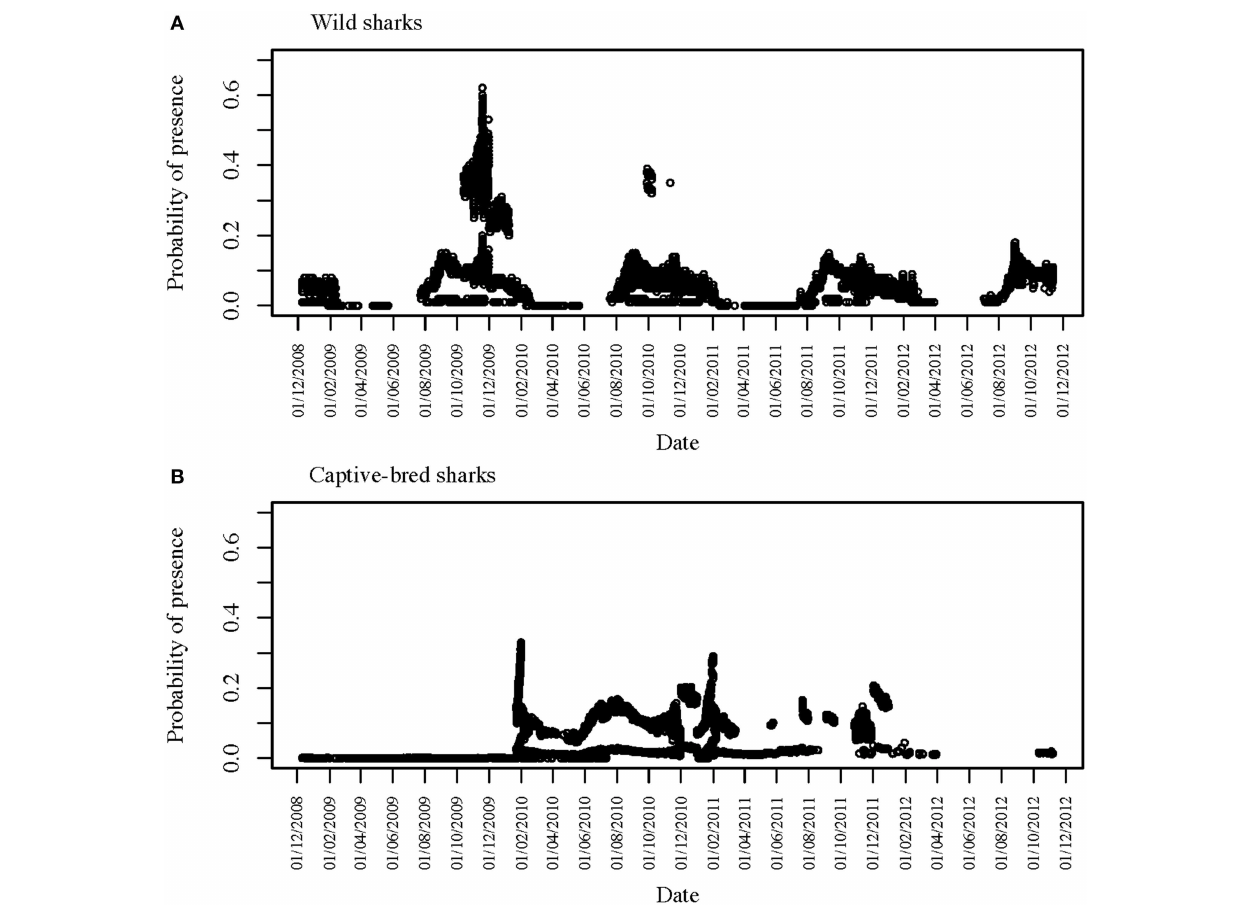
FIGURE 5 | Predicted values from the best GLMM models for the probability of (A) wild and (B) captive-bred wobbegongs being present at CTBAR against month by year.